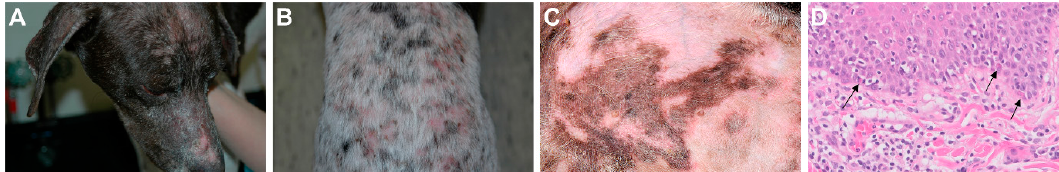
Figure 1. Exfoliative Cutaneous Lupus Erythematosus (ECLE) phenotype. ( A ) Scarring alopecia, generalized hair loss and adherent crusts on the face of a 2-year-old male dog. ( B ) Erythematous lesions on the back of a 1.5-year old male dog. ( C ) Close up of patchy lesions on the abdomen. ( D ) Haired skin from an ECLE affected dog with typical histological changes that include a cell-rich interface inflammation with frequent basal keratinocyte apoptosis (arrows). Hematoxylin and eosin stain.